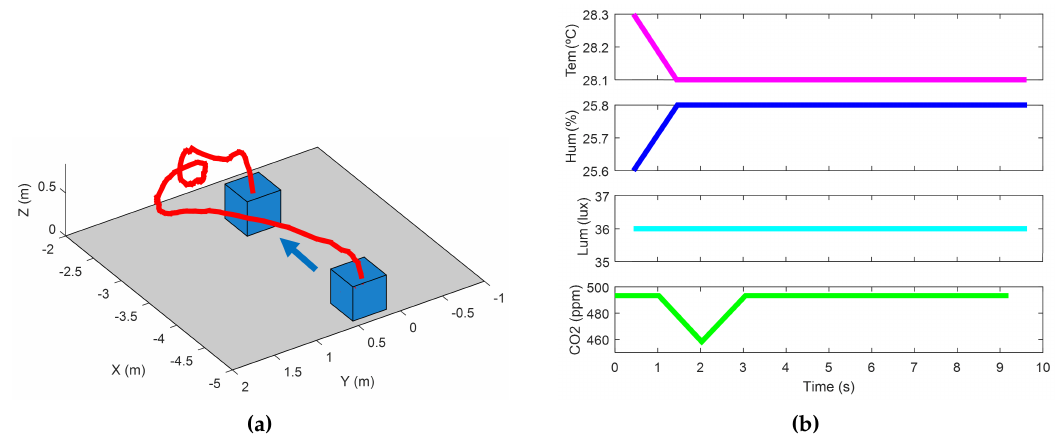
Figure 15. An example of the measurement of environmental variables from the UAV: ( a ) Paths of ground and aerial robots; ( b ) Evolution of environmental variables during the